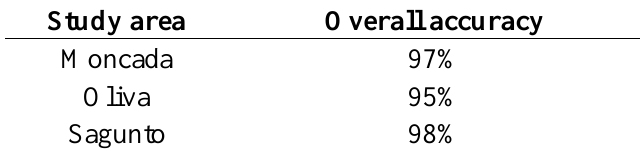
Table 3. Overall classification accuracies obtained in the three study areas.